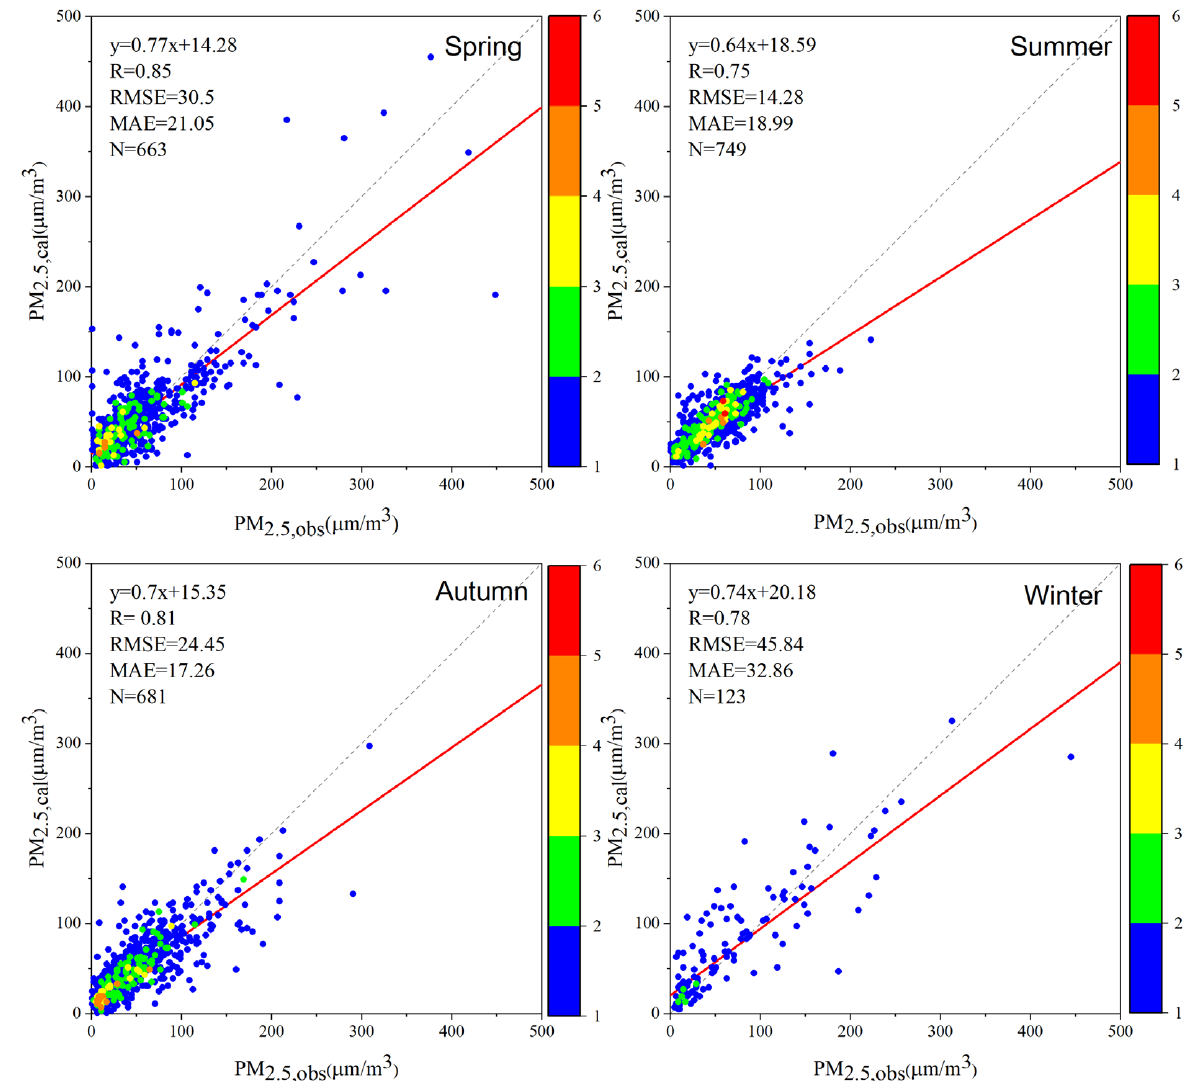
Figure 3. Fitting performance of training set in each season.